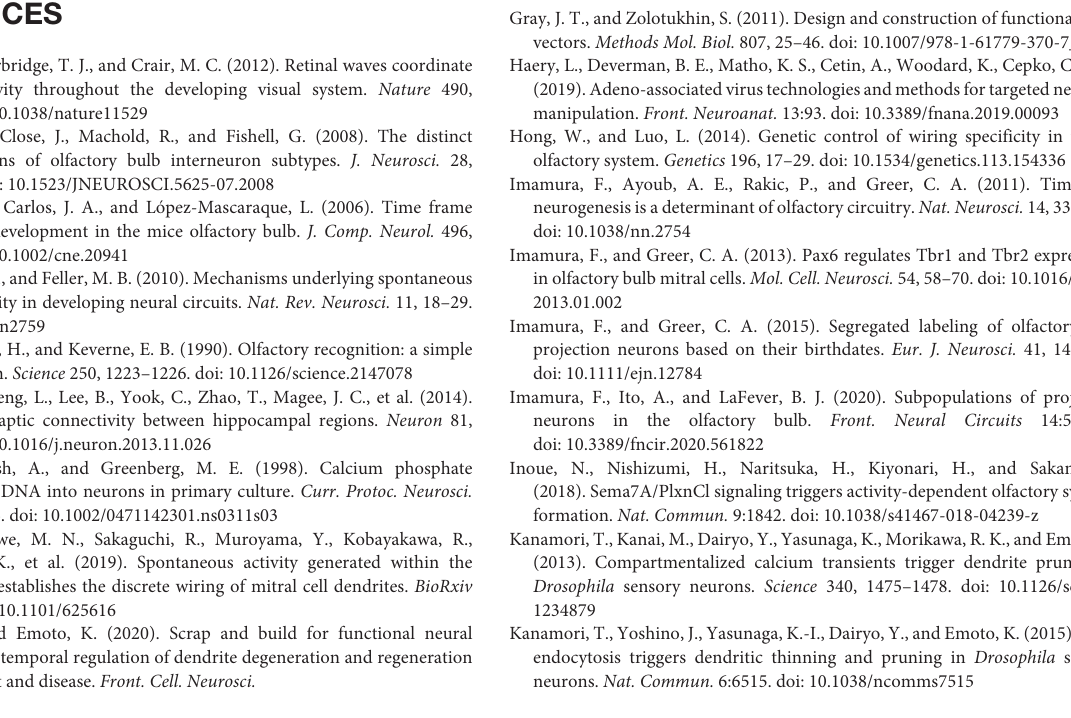
SUPPLEMENTARY FIGURE 1 | The ratio of EdU-labeled cells in EGFP- and Tbx 21- positive cells. (A) The timing of administration of EdU and the ratio of EdU-labeled cells in EGFP-positive and Tbx 21 positive cells. The numbers of mice analyzed are 1, 1, 3, 1, and 3 for E9.5, E10.5, E11.5, E12.5, and E13.5, respectively. (B) The timing of administration of EdU and the ratio of EdU-labeled cells in Tbx21-positive cells. The numbers of mice analyzed are 1, 2, 2, 2, and 2 for E9.5, E10.5, E11.5, E12.5, and E13.5, respectively. The average percentage (blue bars) and the distribution of mice analyzed (circles) are shown. SUPPLEMENTARY FIGURE 2 | Three-dimensional reconstructed confocal images of mitral cells. Images (A–D) corresponds to Figure 6 (A–D) . Images (A,A (cid:48) ) and images (B,B (cid:48) ,B (cid:48)(cid:48) ) are views from different angles of the same neurons. Blue and white arrowheads represent axons and lateral dendrites,